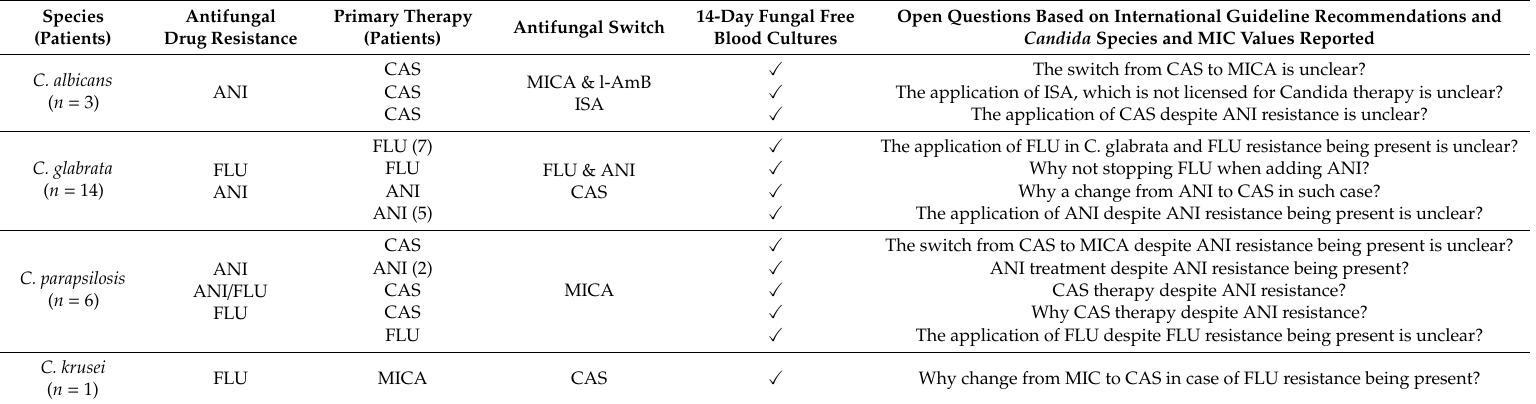
Table 3. Antifungal treatment modalities and species and MIC values provided at the study centers.